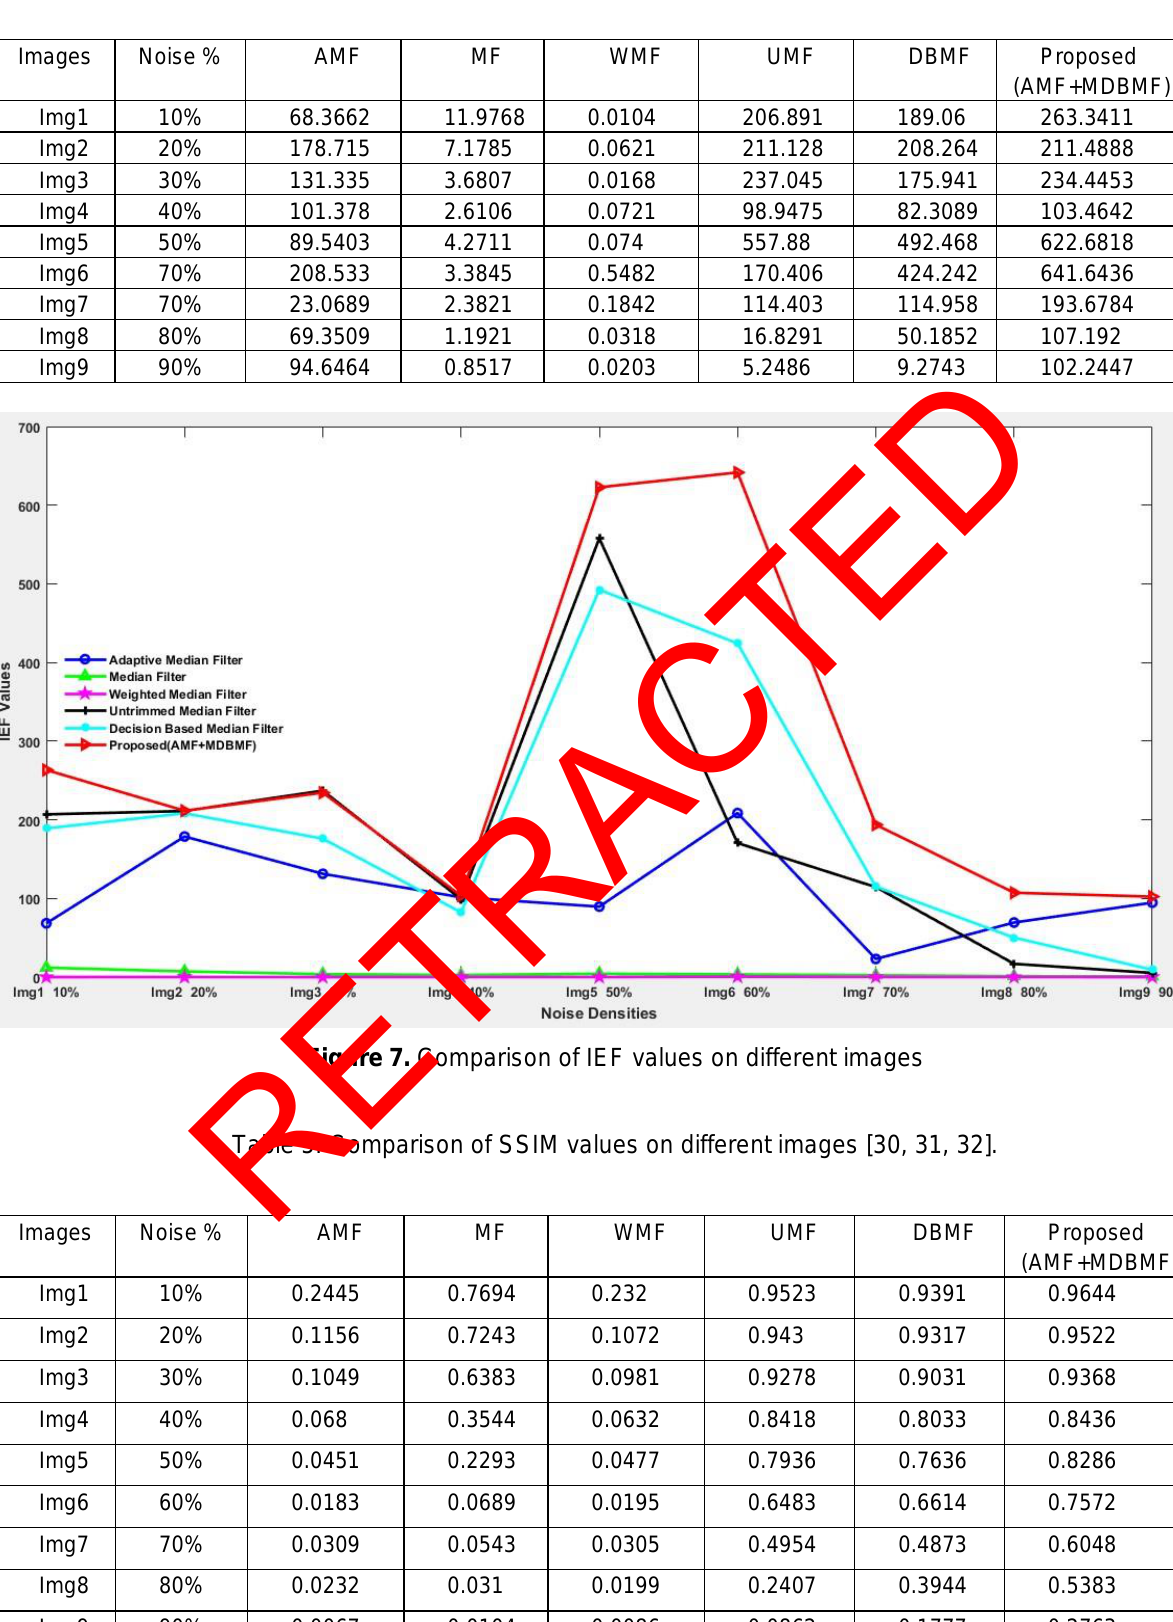
Table 4. Comparison of IEF values on different images.